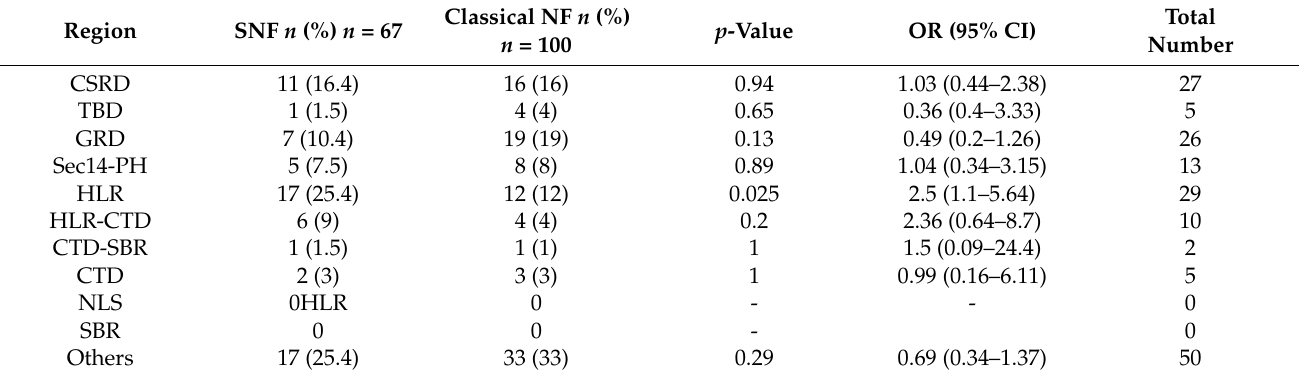
Table 9. Distribution of the NF1 pathogenic variants in different NF1 gene regions between the SNF and classical